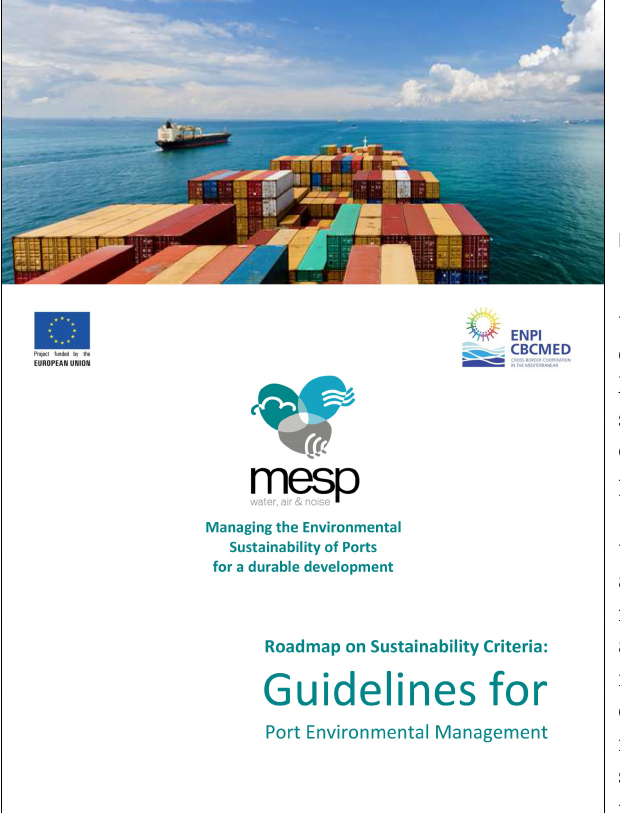
Figure 3: Cover of the “Roadmap on Sustainability Criteria: Guide- lines for Port Environmental Management” document.